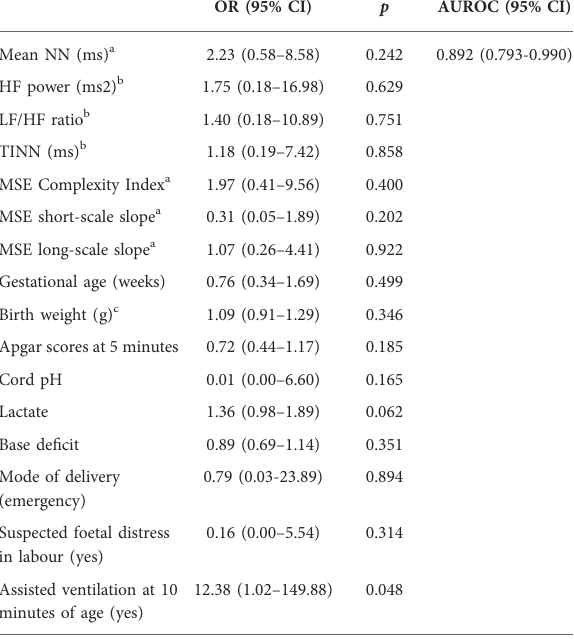
Table 8 Subgroup analysis of infants without anti-seizure medication prior to EEG epoch analysed - HRV and clinical prediction model, n =56